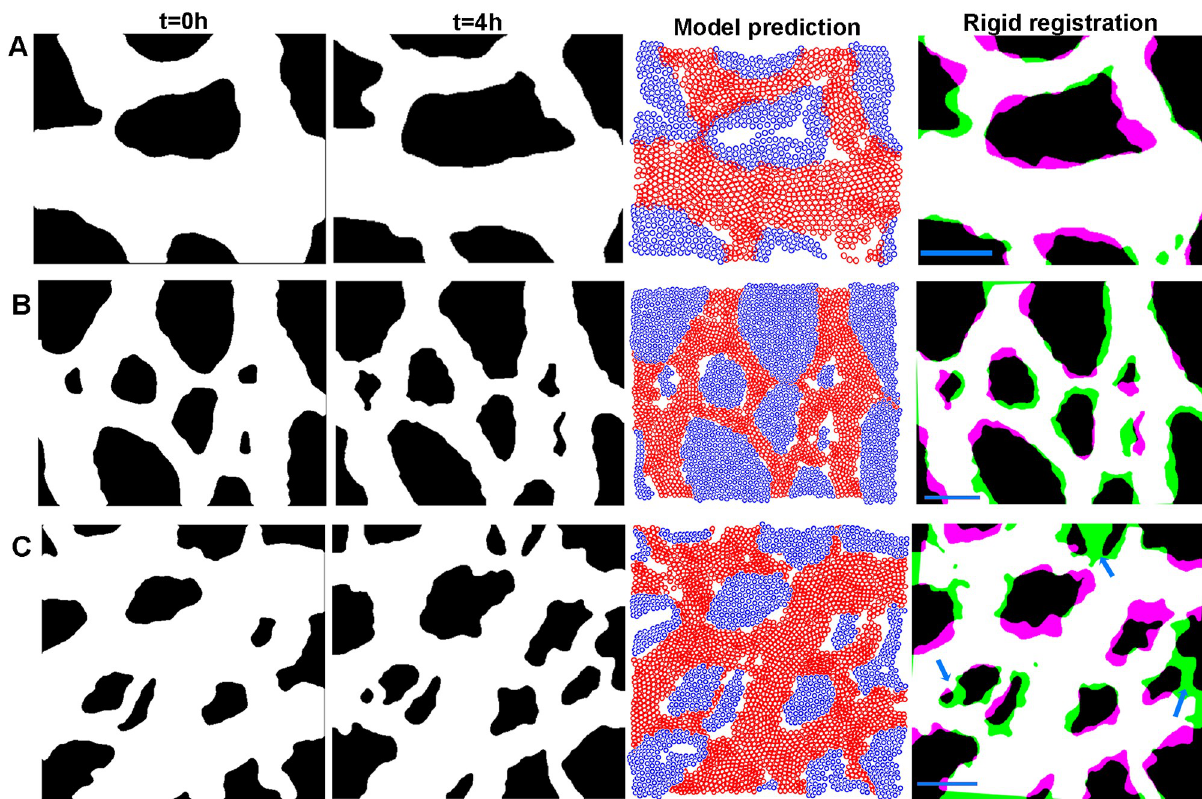
Fig 9. Model cannot accurately predict sprouting angiogenesis. First column shows the shape of vessel at time zero. Second column shows the vessel shape after four hours. Third column shows the vascular and avascular agents at 4h. Fourth column shows the results of rigid registration of the model output on the real final shape. A) Model output for a simple shape. B) Model output for a larger region. C) Model output for a region with sprouting angiogenesis (blue arrows). The parameters used for this model: α = 100, β = 40, z = 0, ω = 20, η = 0.1, κ = 20, β av = 100, ω av = 10, and κ av = 10. Scale bar = 100 μm